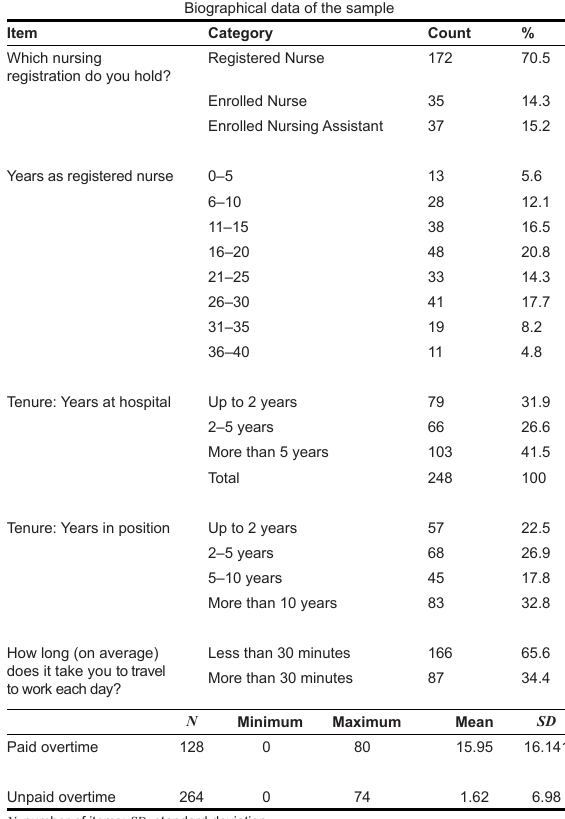
TABLE 2(a) Biographical data of the sample